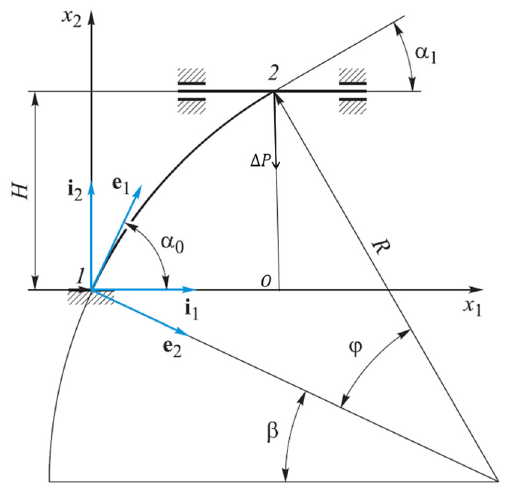
Figure 6. Scheme for determining displacements flat curved rod.